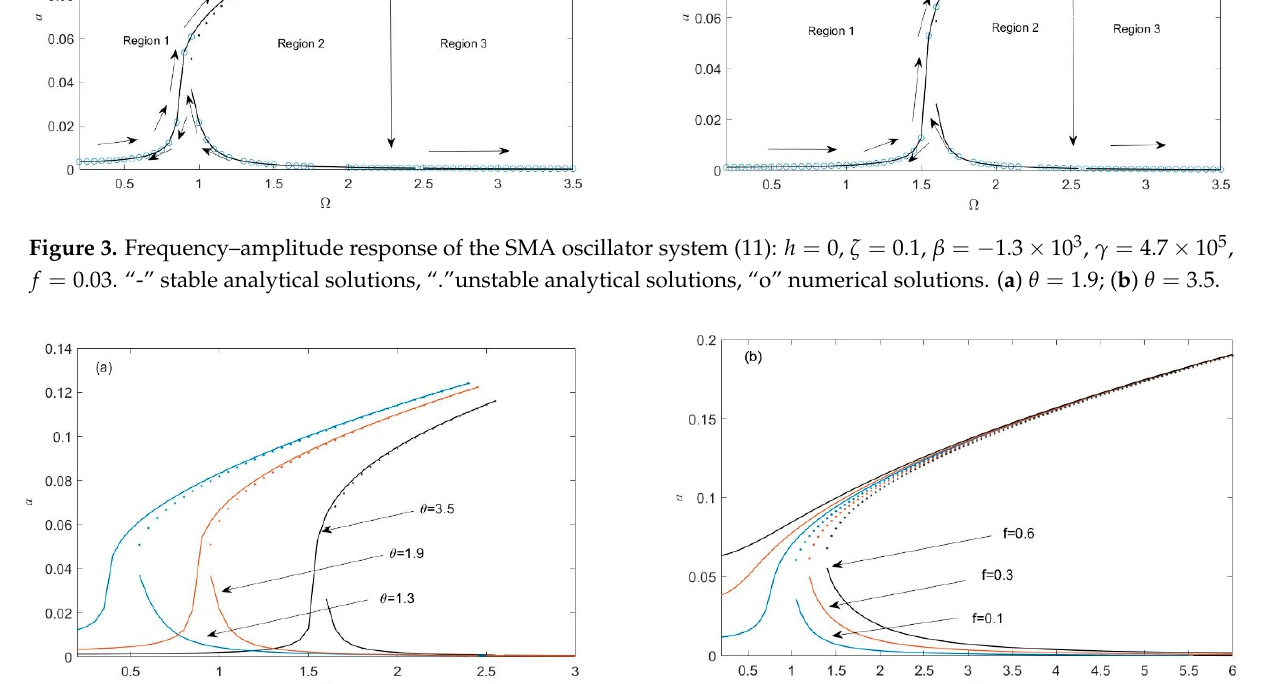
Figure 3. Frequency–amplitude response of the SMA oscillator system (11): ℎ = 0 , 𝜁 = 0.1 , 𝛽 = −1.3 × 10 (cid:2871) , 𝛾 = 4.7 × 10 (cid:2873) , 𝑓 = 0.03 . “ - ” stable analytical solutions, “.”unstable analytical solutions, “o” numerical solutions. ( a ) 𝜃 = 1.9 ; ( b ) 𝜃 = 3.5 .